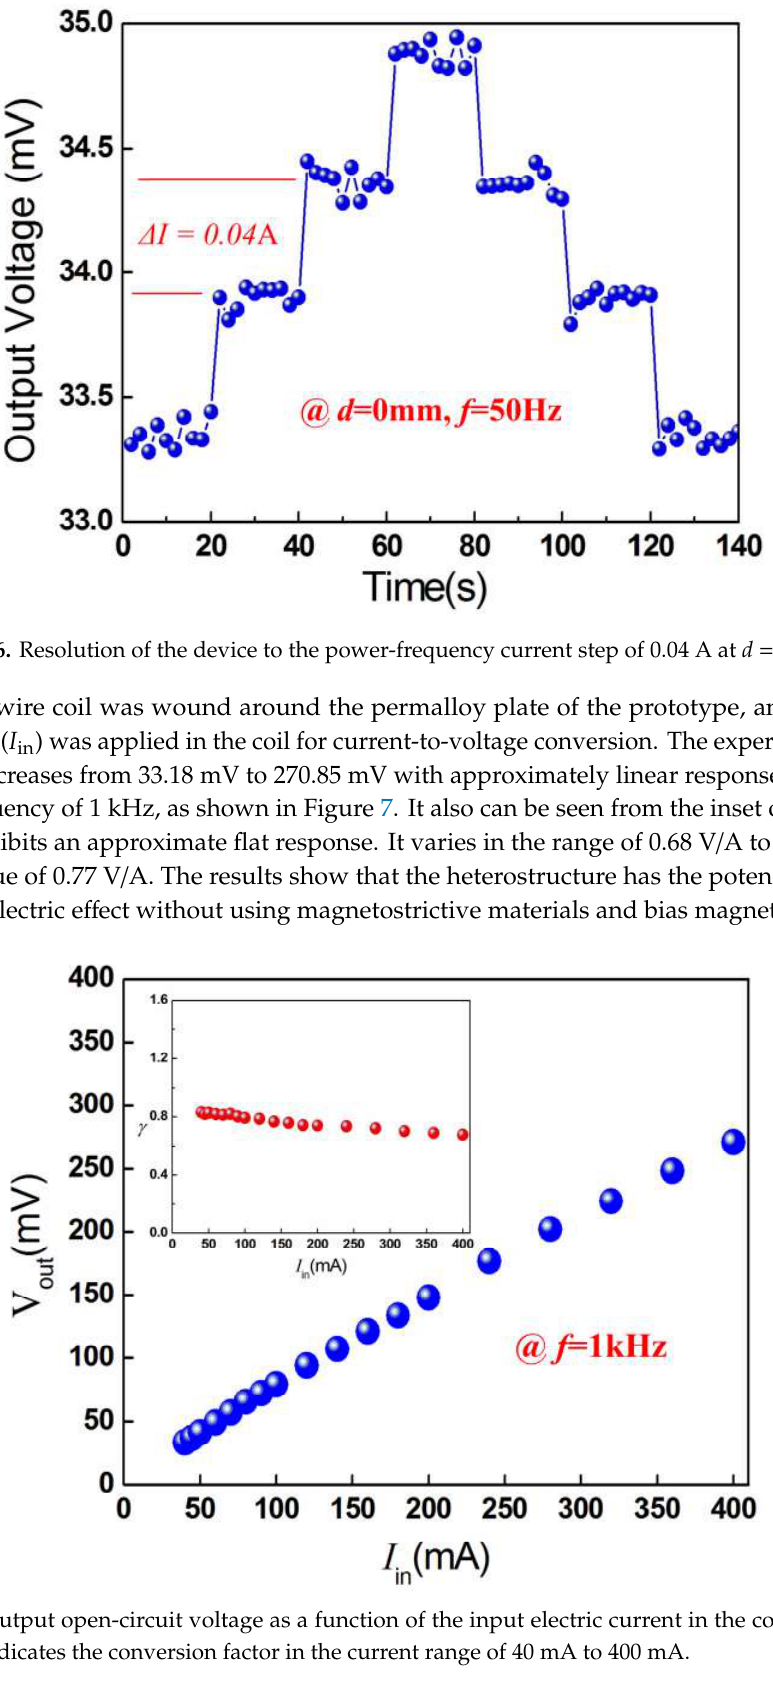
Figure 7. Output open-circuit voltage as a function of the input electric current in the coil at 1 kHz. The inset indicates the conversion factor in the current range of 40 mA to 400 mA.